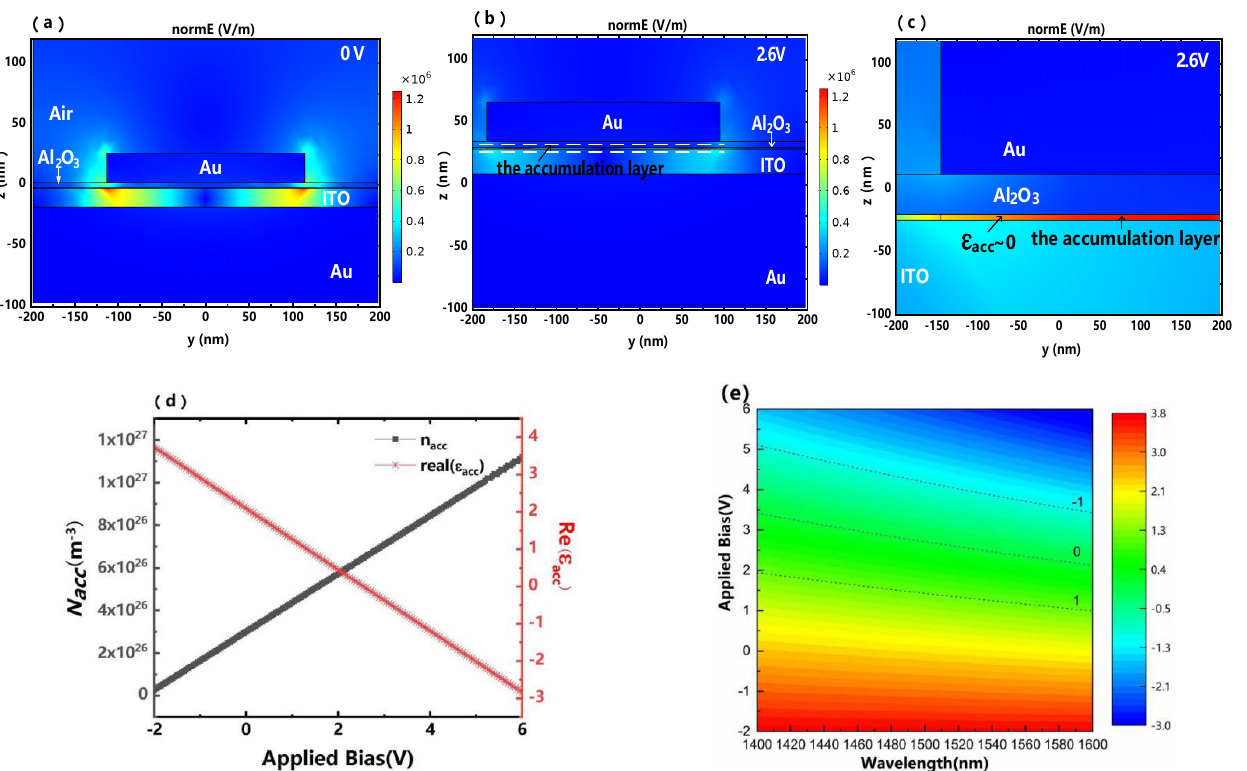
Figure 2. ( a , b ) is the spatial distribution of the z component of the electric field Ez for applied biases of 0 V and 2.6 V, and ( c ) is the magnified accumulation region near the Al 2 O 3 /ITO interface of 2.6 V applied bias at the wavelength of 1550 nm. The legend represents the magnitude of the electromagnetic field. Simulated ( d ) is the carrier concentration, and the permittivity of the ITO accumulation layer varies due to gating applied voltage at λ = 1550 nm. The black line shows carrier concentration variation, and the red line represents different permittivity from − 2.8 to 3.7 at the Al 2 O 3 /ITO interface. Simulated ( e ) is the real part of the permittivity spectrum at different bias voltages and wavelengths. The legend represents the value of the dielectric constant at different wavelengths.